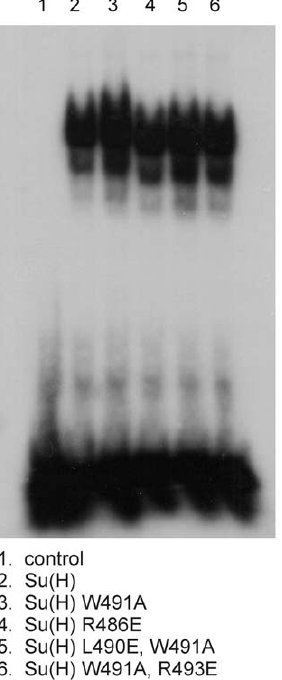
Figure 2. DNA binding is not altered in Su(H) mutants. Electromobility shift assay for binding of Su(H) protein variants to the radiolabelled E(spl) m8-S1 oligo [44]. Control, no protein added (lane 1). The binding of the mutant Su(H) WA , Su(H) RE , Su(H) LEWA , or Su(H) WARE proteins (lane 3–6) to DNA was similar as the wild-type Su(H) protein (lane 2).